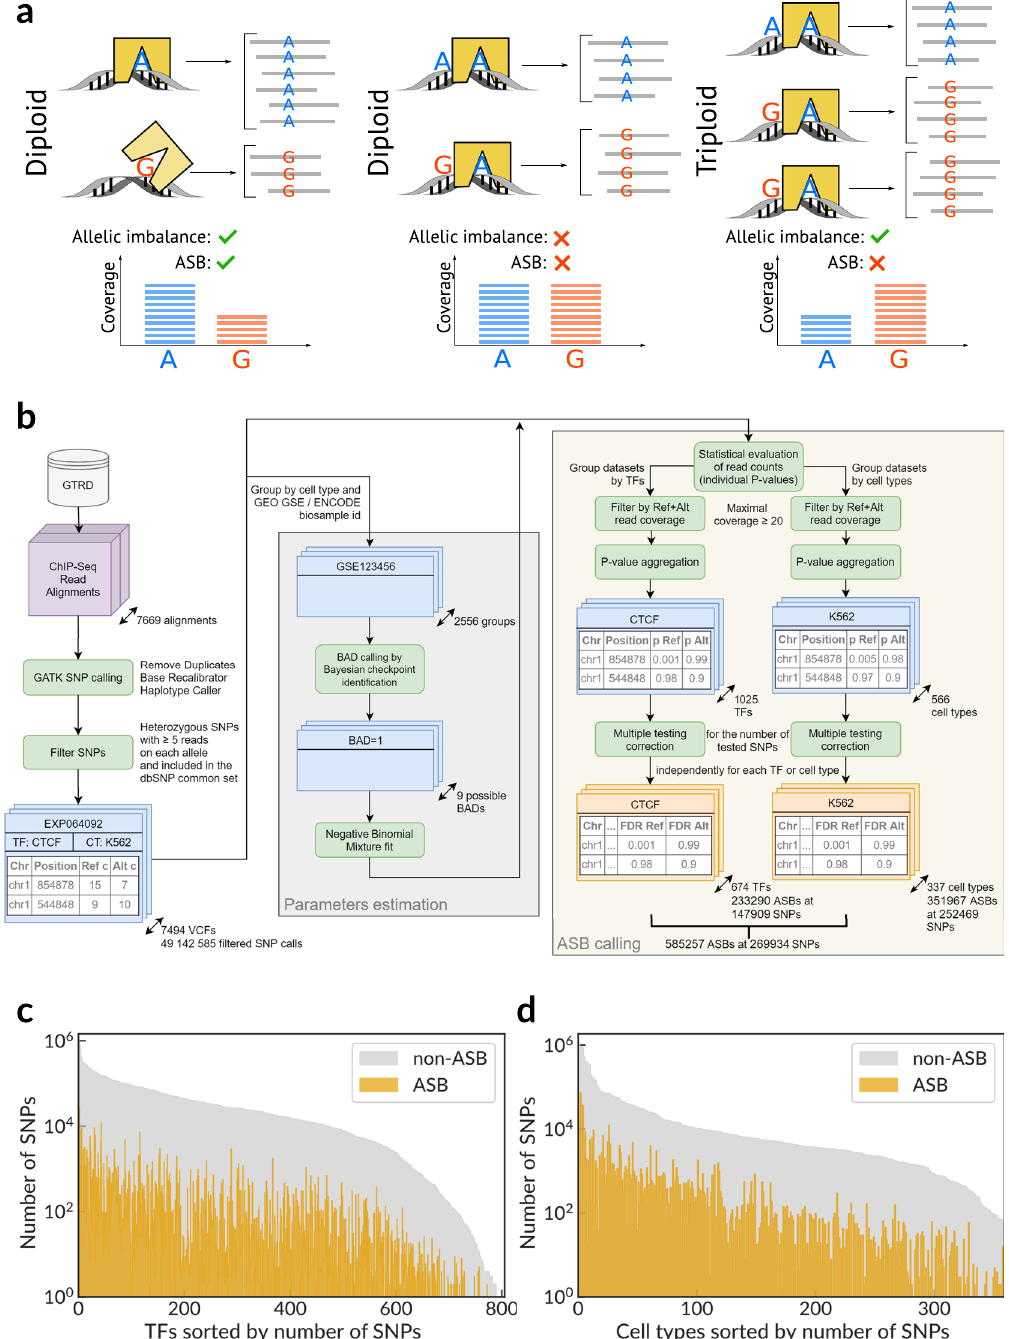
Fig. 1 A scheme of allele-speci fi c binding events, an overview of the ADASTRA pipeline, and its application to ChIP-Seq data. a ChIP-Seq data allow detecting ASB events by estimating the imbalance of reads carrying alternative alleles. ASBs must be distinguished from sites where the allelic imbalance is caused by aneuploidy and copy-number variants. b The scheme of the ADASTRA pipeline: variant calling in read alignments from GTRD, estimation of statistical model parameters and background allelic dosage, fi ltering, and statistical evaluation of candidate ASBs. ADASTRA generates two complementary data sets: transcription factor ASBs (pairs of an SNP and a TF) and cell type ASBs (pairs of an SNP and a cell type). SNPs are annotated according to dbSNP IDs. c , d Number of SNPs (dbSNP IDs, Y -axis) with signi fi cant ASB events for various transcription factors and for various cell types. TFs or cell types ( X -axis) are sorted by the number of SNPs. SNP single-nucleotide polymorphism, BAD background allelic dosage, ASB allele-speci fi c binding, GTRD gene transcription regulation database, ADASTRA Allelic Dosage-corrected Allele-speci fi c human Transcription factor binding sites.